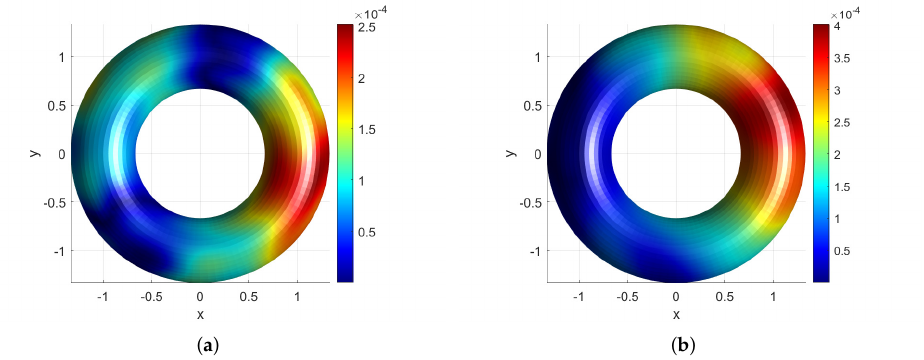
Figure 5. Example 2: Snapshots of absolute error distribution under width = 50 and depth = 4: ( a ) by using quasi-uniform training data and ( b ) by using randomly distributed training data.